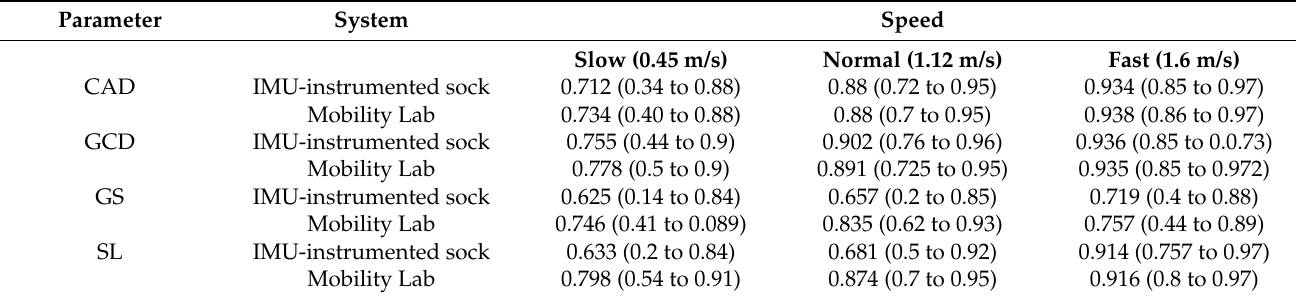
Table 2. Intersession reliability of the spatio-temporal parameters estimated by the TEADRIP algorithm applied to the IMU-instrumented sock recordings and those estimated by the Mobility Lab system for treadmill walking in HP. Intra Class Correlation Coefficient (ICCs) and their 95% CI for the treadmill 2MWT at slow, normal, and fast walking speeds. Parameter